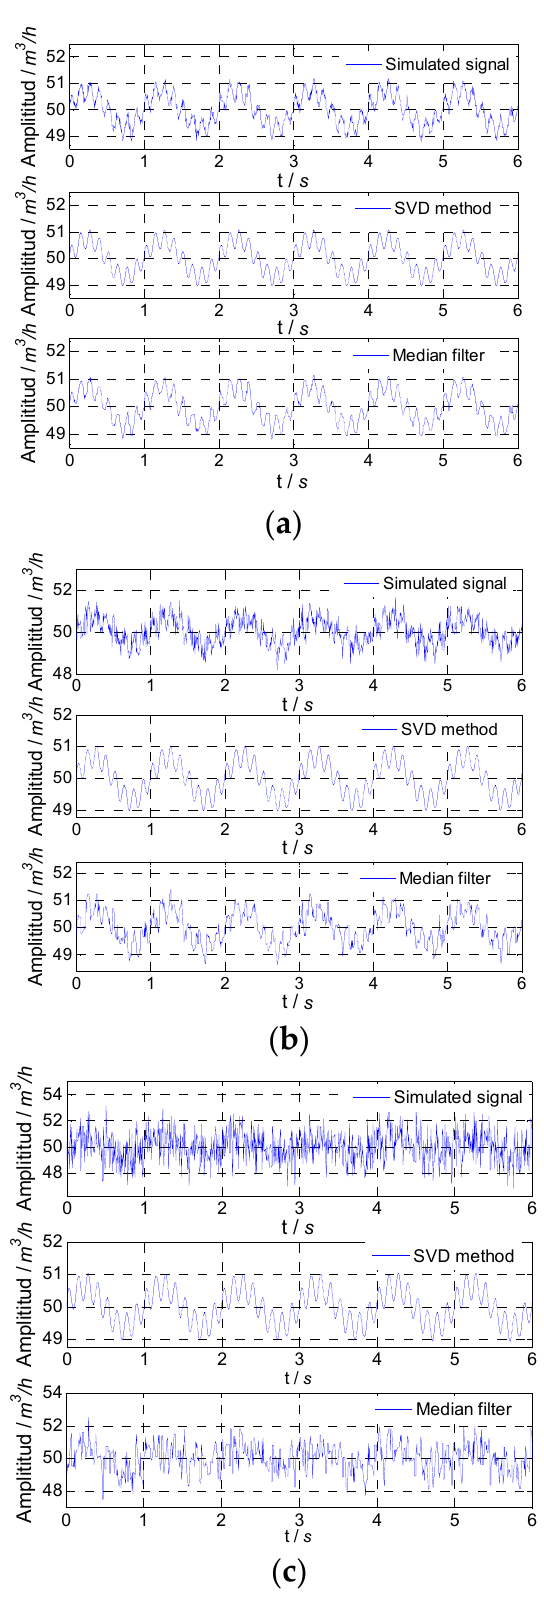
Figure 5. Simulated result for superposition signal: ( a ) noise variance, 0.01; ( b ) noise variance, 0.1; ( c ) noise variance, 1. Table 3. Amplitude attenuation and SNR improvement for superposition signal.